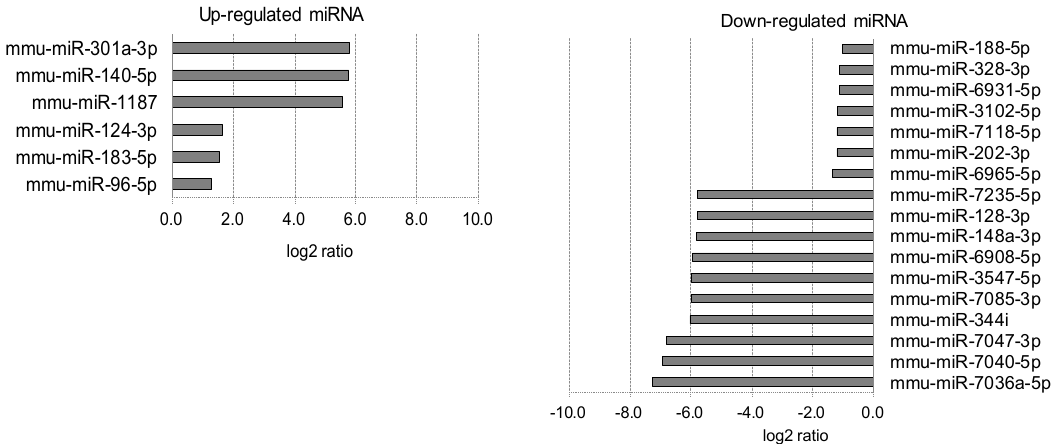
Figure 6. Lens miRNAs affected by myopia induction. The lens miRNAs whose expression was affected by myopia induction are listed as upregulated ( left ) and downregulated ( right ).